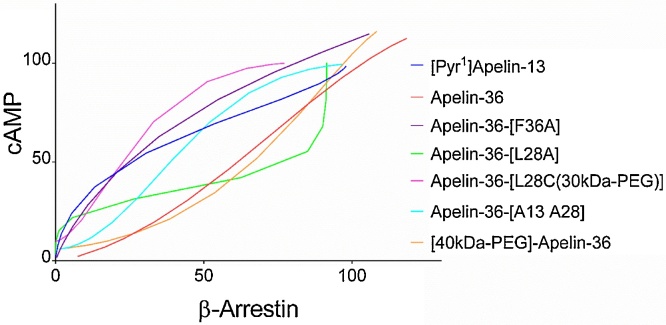
Bias plot for apelin-36 and analogues in cAMP and β-arrestin assays. Curves show the corresponding responses in each assay to equivalent concentrations of apelin-36 and analogues in CHO-K1 cells expressing the apelin receptor. Deviation in the shape of the curves indicates ligand bias at the receptor level. Responses in the cAMP assay were expressed as % inhibition of the forskolin response and in the β-arrestin assay as % of the maximal response to [Pyr1]apelin-13.